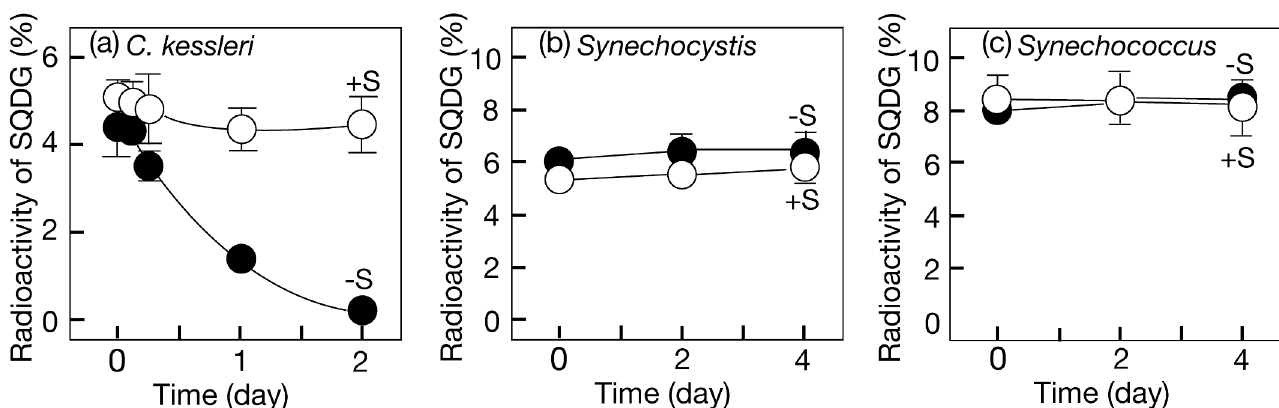
Fig 2. Effect of S-starvation on the stability of SQDG. Cells, which had been universally labeledwith 35 S, were transferred to non-label+S ( 32 S, open circles) or -S conditions (closedcircles), and thereafter the radioactivity of SQDG, relative to that in cells, was determined with time in C . kessleri (a), Synechocystis (b), and Synechococcus (c). The values shown are the averages ± SD for three distinct groups of data.